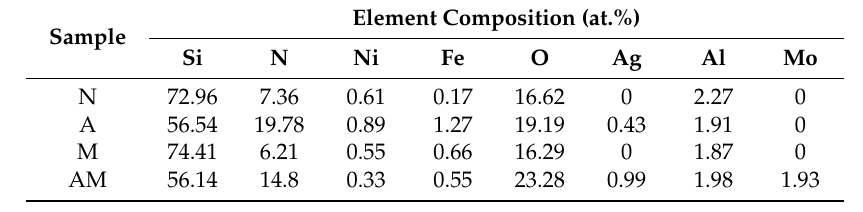
Table 3. The element compositions of the worn surfaces of all counterface balls.